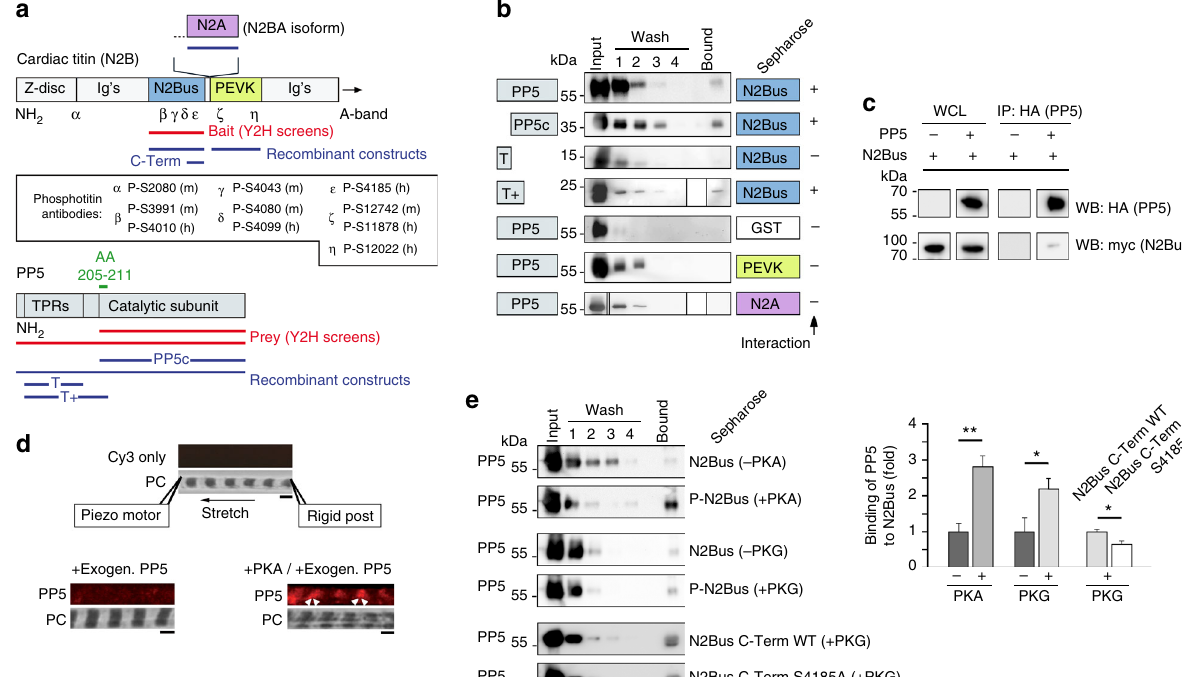
Fig. 1 The elastic N2Bus domain of titin interacts with PP5. a Domain arrangement in the Z-disk/I-band region of cardiac titin N2B/N2BA isoforms and in PP5. Constructs generated for yeast-two-hybrid (Y2H) screens marked in red, those for GST-pulldown assays in blue, and N2Bus-binding amino acids (AA) of PP5 in green. Ig ’ s, immunoglobulin-like domains. Inset: Epitope positions of all phospho-titin antibodies used in this study. (m), anti-mouse; (h), anti-human. b Summary of results of GST-pulldown assays probing interaction of N2Bus with full-length PP5, PP5 catalytic subunit (PP5c), or N-terminal PP5 fragments (T; T+). PP5-binding to PEVK or N2A titin domains was also tested. GST, glutathione S transferase (for negative control). Each test was performed a minimum of two times, mostly three times, with identical results. c Demonstration of PP5-N2Bus association by co-immunoprecipitation assay. PP5 (HA-tag) immunoprecipitations (IP) and whole-cell lysates (WCL) from HEK cells analyzed by western blot for N2Bus (myc-tag) and PP5. PP5 -/+indicates absence/presence of PP5 in the assay. This test was performed three times, with identical results. d Binding of PP5 to sarcomeric I-bands is enhanced by phosphorylation. Top: the experimental design for the stretching of single myo fi brils and immuno fl uorescence image of stretched human cardiac myo fi bril incubated in relaxing buffer with Cy3-conjugated secondary antibodies alone (control), as well as phase-contrast image (PC). Bottom: representative images of myo fi brils incubated with exogenous PP5c and stained against PP5c. The myo fi bril on the right was incubated with catalytic subunit of PKA before PP5c-treatment (arrowheads, I-band localization of PP5). Binding visualized by anti-PP5c primary and Cy3-conjugated secondary antibodies. Similar results were obtained from four other myo fi brils per group. Bars, 2 µ m. e Results of GST-pulldown assays probing interaction of PP5 with unphosphorylated N2Bus or N2Bus phosphorylated by PKA/PKG, as well as wildtype (WT) and S4185A mutant of C-terminal N2Bus fragment, both phosphorylated by cGMP-activated PKG. Left: representative immunoblots using anti-PP5 antibody. Right: relative signal intensities in ‘ Bound ’ lane, normalized to the mean intensity of the respective non-phosphorylated/C-Term WT control. Data are mean ± s.e.m., n = 4 assays/condition. * p < 0.05 and ** p < 0.01, by two-tailed Student ’ s t titin 13 ) to alanine and used the wildtype (WT) and S4185A N2Bus constructs, phosphorylated by cGMP-activated PKG, in GST-pulldown assays with PP5. A small but signi fi cant decrease